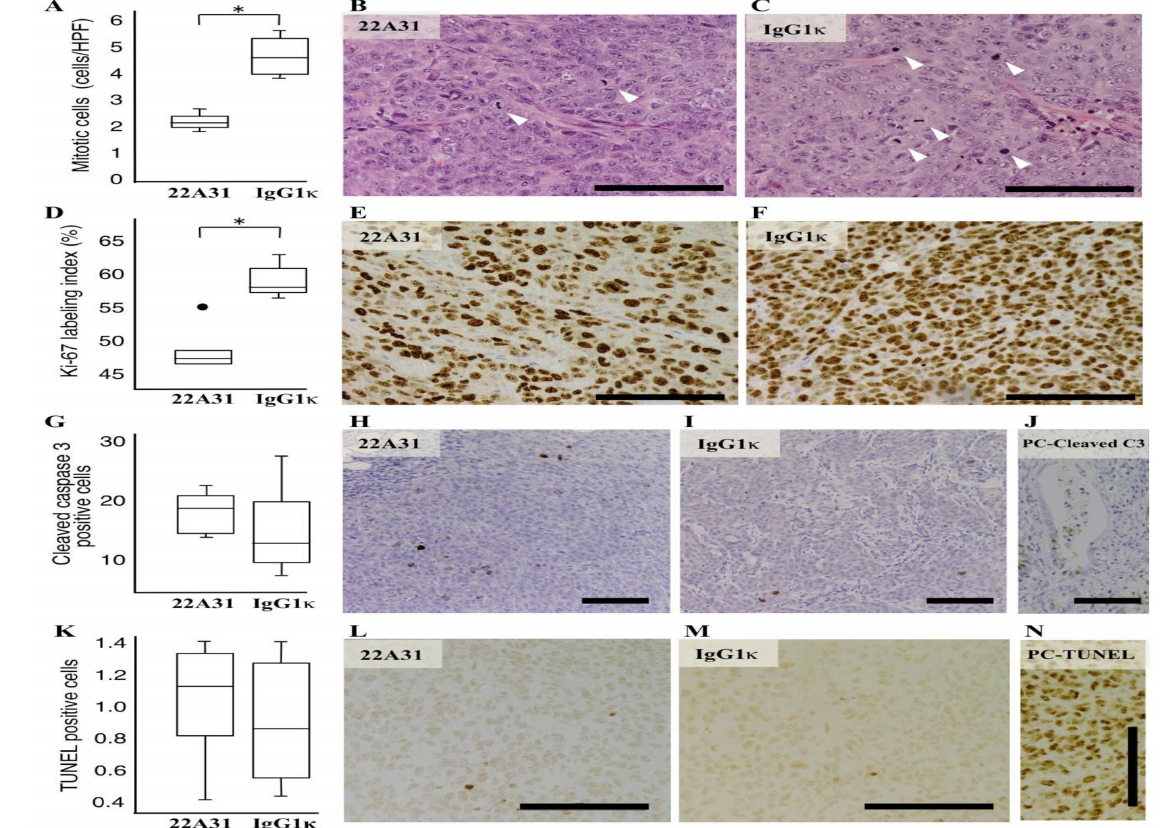
Figure 3. Characteristic difference in HCT116 human colorectal adenocarcinoma tumors between 22A31 and IgG1 κ treatment groups. ( A ) The average mitotic cell number in a field of view at 400 × magnification. * p < 0.05. ( B , C ) Representative images of hematoxylin and eosin staining in tissues from mice in 22A31 and IgG1 κ treatment groups. Mitotic cells are indicated by white arrowheads. ( D ) Ki67 labeling index at 400 × magnification. * p < 0.05. ( E , F ) Representative images of Ki67 staining in 22A31 and IgG1 κ groups. ( G ) The average cell numbers in a field of view showing positive cleaved caspase 3 staining at 200 × magnification. ( H , I ) Representative images of cleaved caspase 3 staining in tissues from mice in 22A31 and IgG1 κ treatment groups. ( J ) Colon carcinoma tissue was used as a positive control of cleaved caspase 3 staining [30] ( K ) The average cell